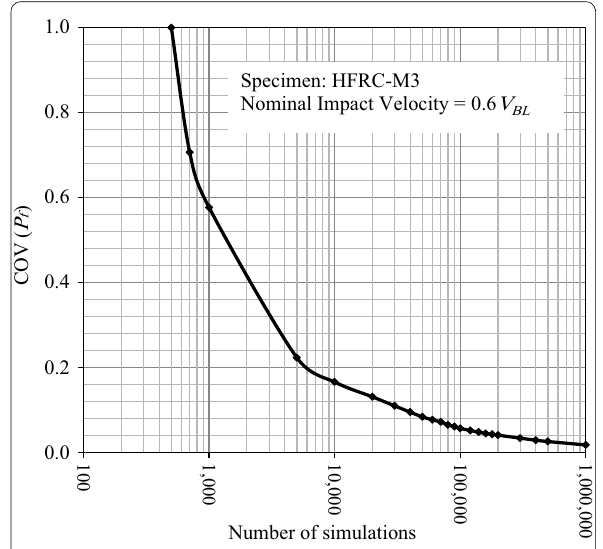
Fig. 4 Effect of simulation cycles on the convergence of P f ( V BL estimated nominal ballistic =